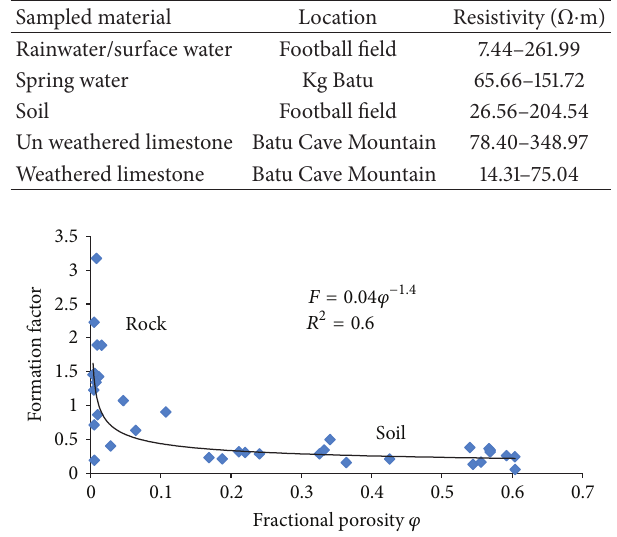
Figure 5: Variation of formation factor against porosity of rock and soil